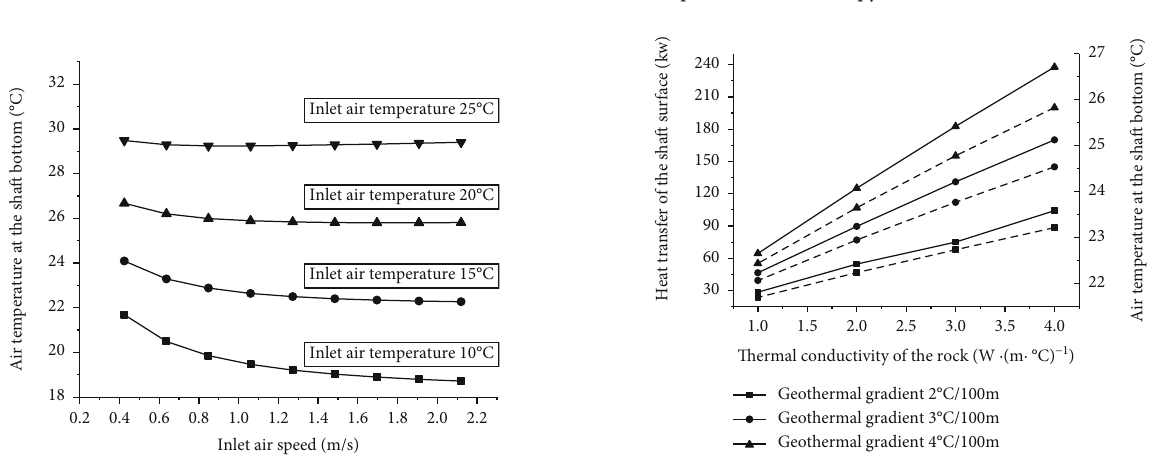
Figure 9: E ff ect of the surface moisture coe ffi cient on the air temperature and enthalpy at the shaft bottom.